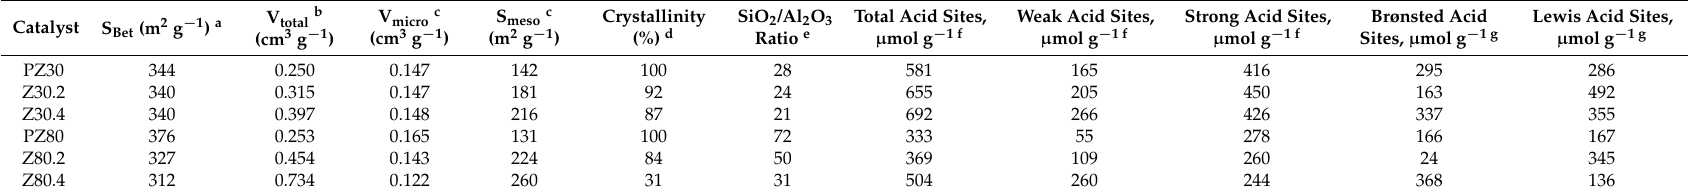
Table 1. Physical properties of untreated and treated H-ZSM-5 Z30 and Z80